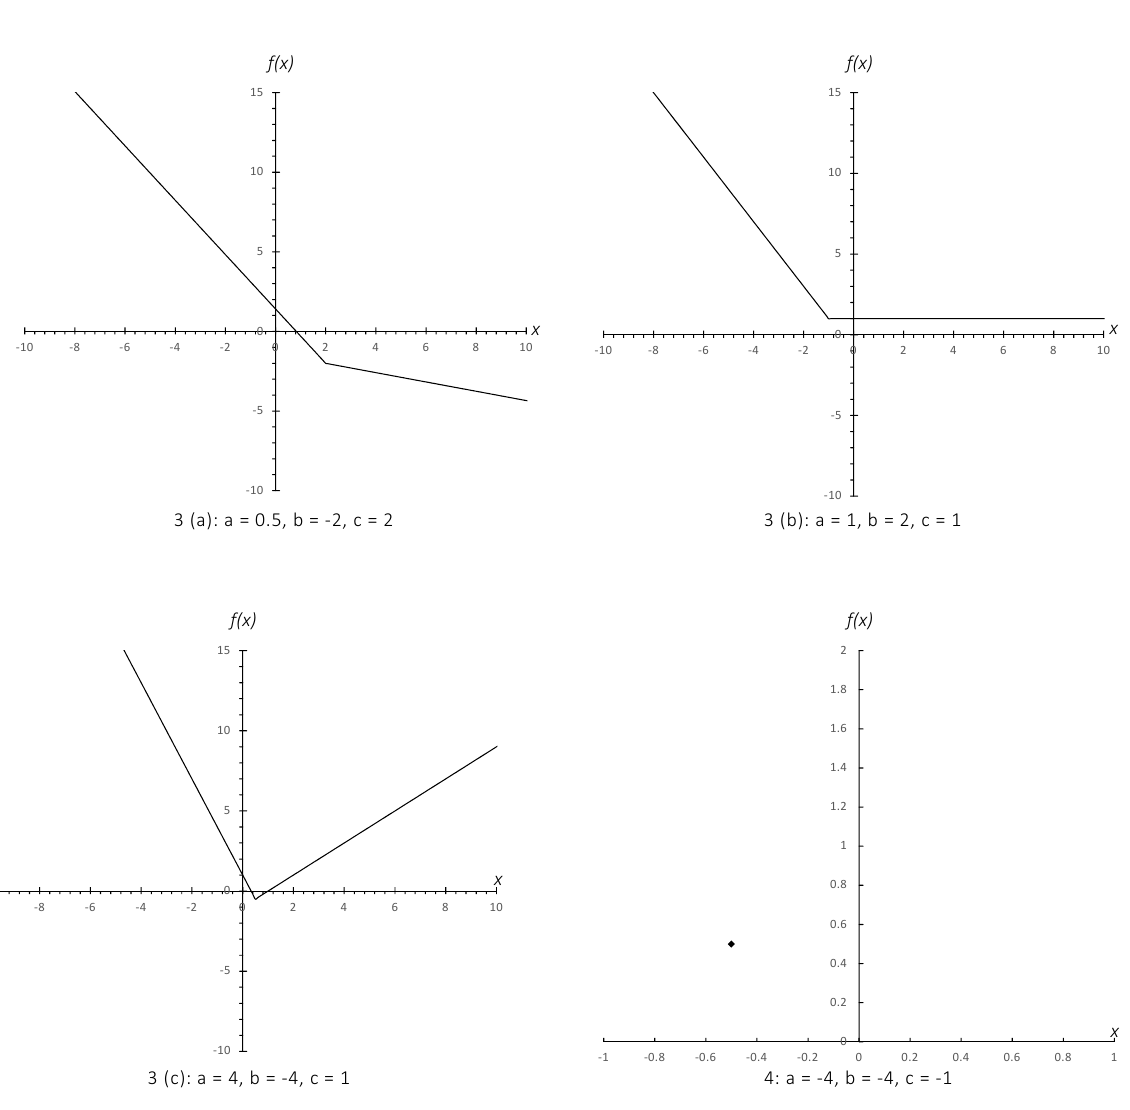
Figure A2. The graph of f ( x ) for Case 3(a) through Case 4 from Theorem